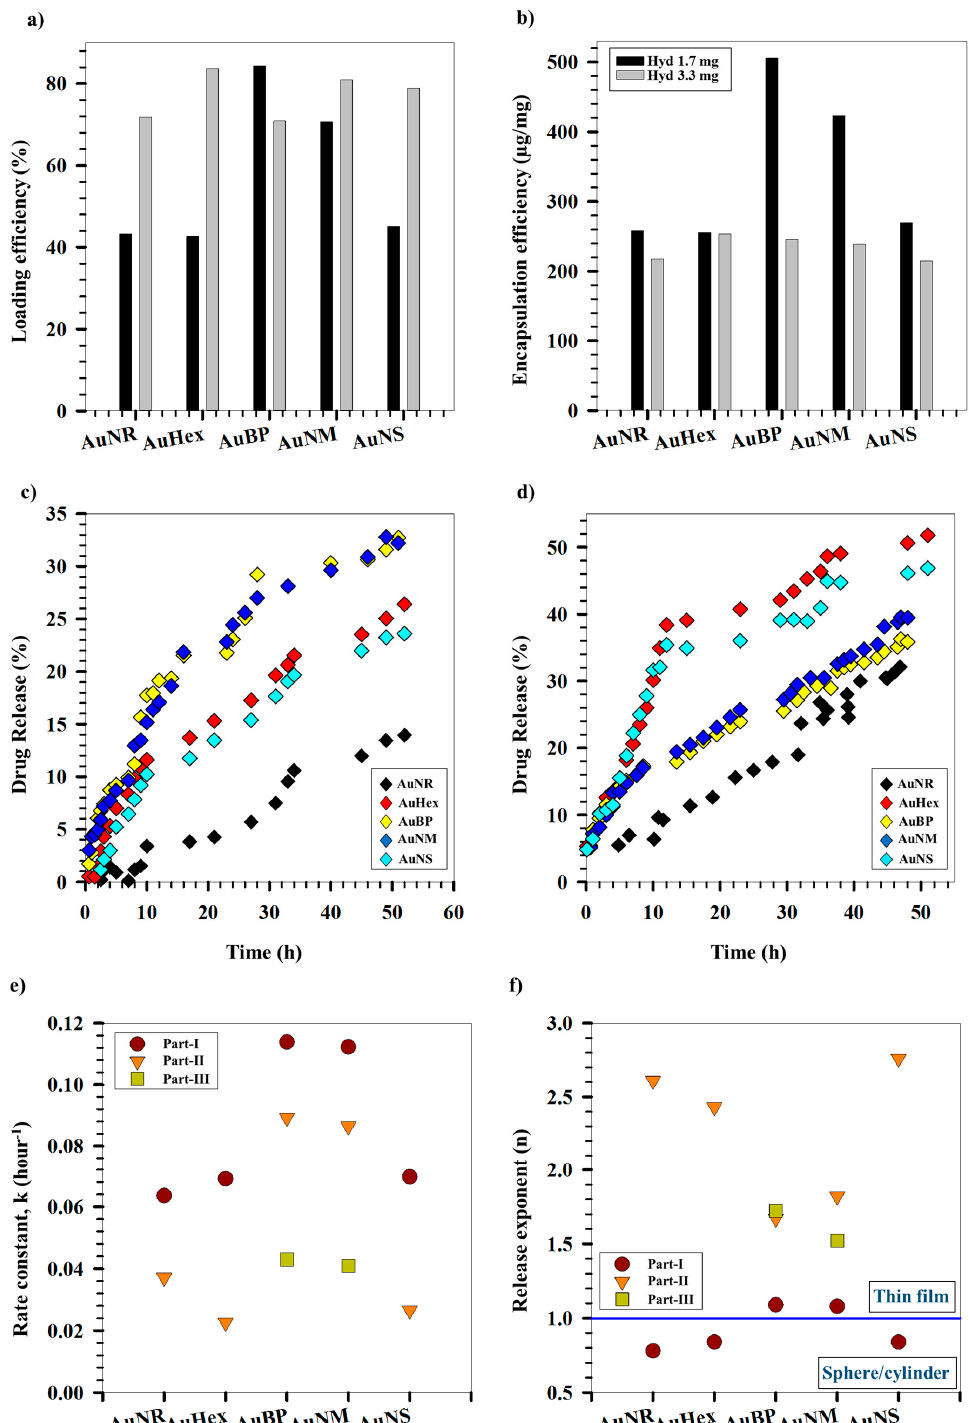
Figure 5. ( a ) Loading and ( b ) encapsulation efficiencies for differently shaped AuNPs for two different hydrogel concentrations. Release kinetics of Cyt C from differently shaped AuNPs for ( c ) 1.7 mg/mL and ( d ) 3.3 mg/mL hydrogel concentrations respectively. ( e ) Rate constants and ( f ) release exponents for Cyt C release from differently shaped AuNPs.